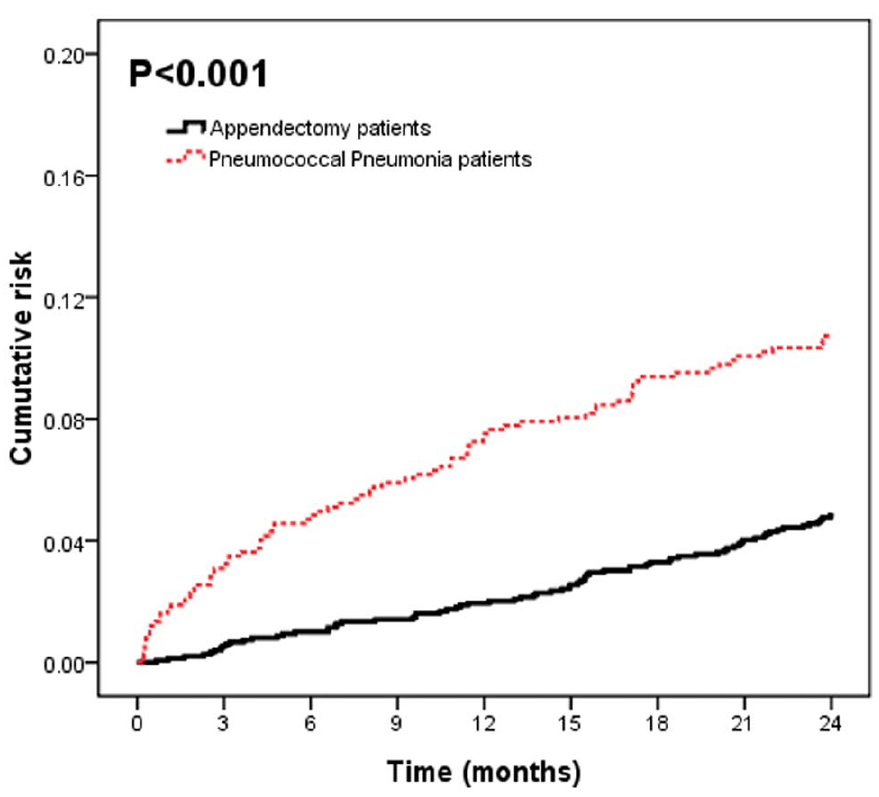
Figure 1. Cumulative risk of stroke for the pneumococcal pneumonia patients and the controls.